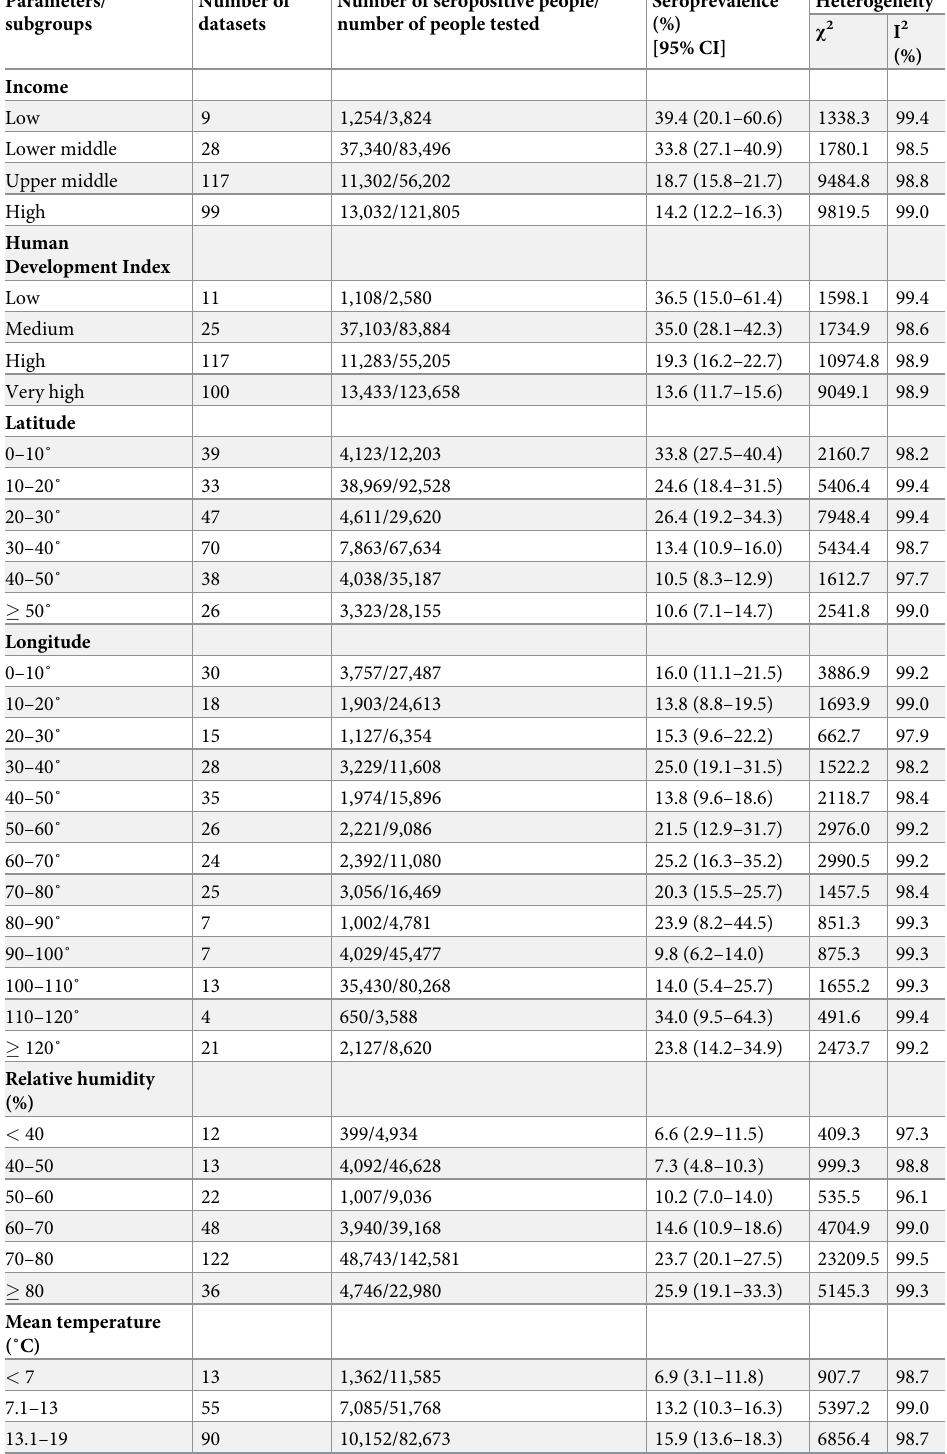
Table 3. T -seroprevalence in the general population based on sub-groups according to different socio-demo- graphic and geographic parameters, calculated using a random effects model (REM). Parameters/